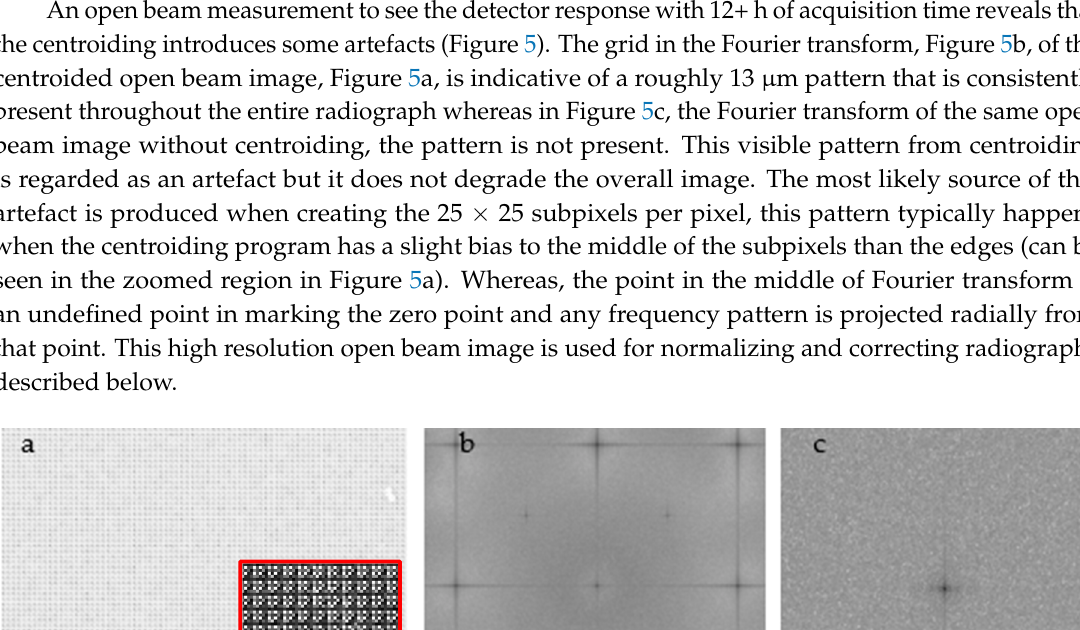
Figure 4 . Neutron TOF image for the cold neutron radiograph energy region showing individual events( a ). Zoomed in section of (a) marked by red dashed rectangle ( b ). Illustrated sub-pixel break down for a single neutron event marked by red dashed area in ( c ). One single 55 μ m pixel is converted into a 5 × 5 subpixel array with sizes of 11 μ m each. The red square indicates where the event will be centroided to a single sub pixel.